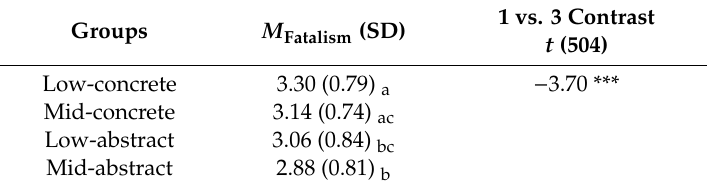
Table 6. Contrast between the low and middle-low status in fatalism